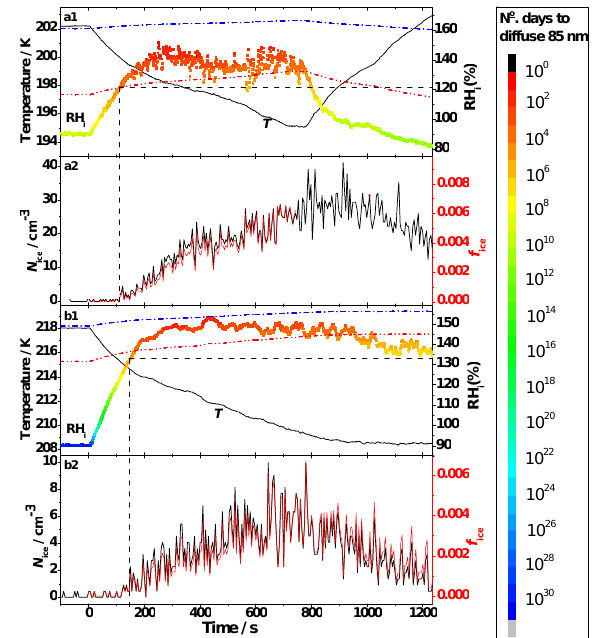
Fig. 9. Time series for ice production runs using raffinose/M5AS solution aerosol (a1, a2) and raffinose solution aerosol (b1, b2) . The temperature trajectories are shown as solid black lines in pan- els (a1) and (b1) . In these panels the RH i trajectories are displayed as colour mapped time series, the colour maps correspond the es- timated time taken for water molecules in the aerosol particles to diffuse 85nm (the average radius of particles in this study), see Sect. 3.3 for details. The humidity at which homogeneous ice nu- cleation is expected is shown in both cases as a dash-dot blue line. RH g is shown as red dot-dot-dash lines. The ice particle number concentration ( N ice ) and fraction frozen ( f ice ) are shown as black and red lines respectively. The onset of ice nucleation is represented in each case by black dashed